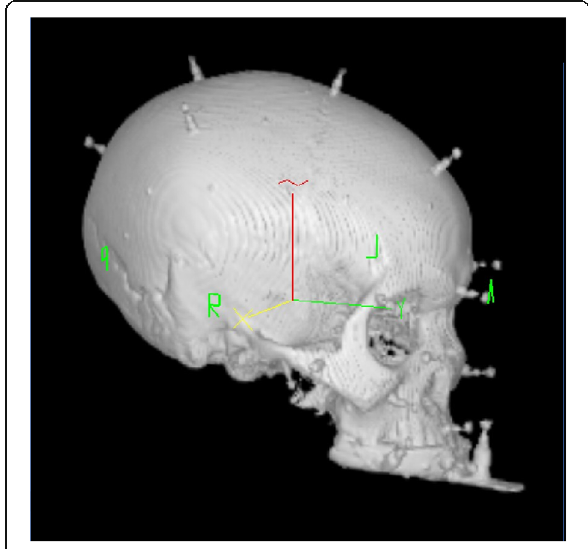
Fig. 3 Three-dimensional reconstructed computed tomography of the skull with an inserted maxillary splint and twenty additionally inserted bone markers for metric accuracy